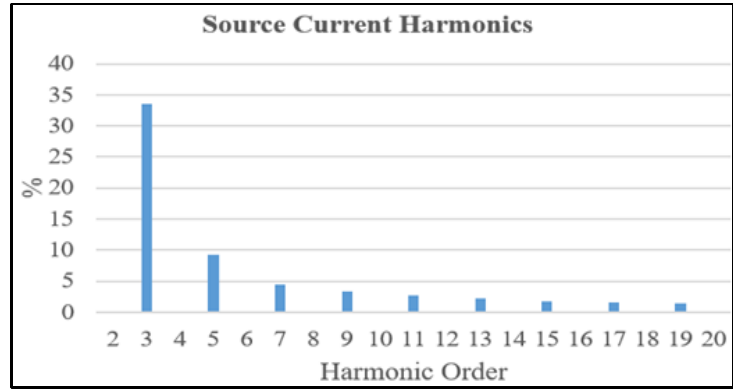
Figure 6. Source Current Harmonics When No Filter Is Employed.